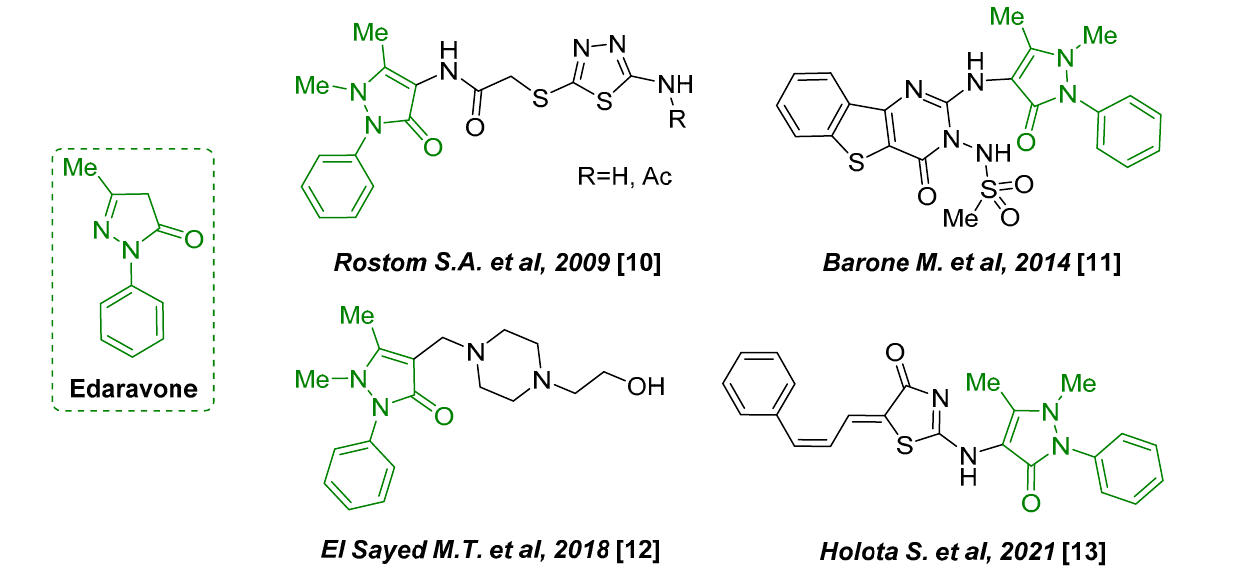
Figure 1. Structures of edaravone and antipyrine-heterocycle hybrid molecules with anti-inflammatory properties.